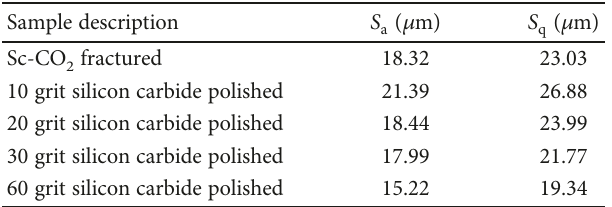
Table 2: Comparison of topography between arti fi cial samples and Sc-CO -fractured 2